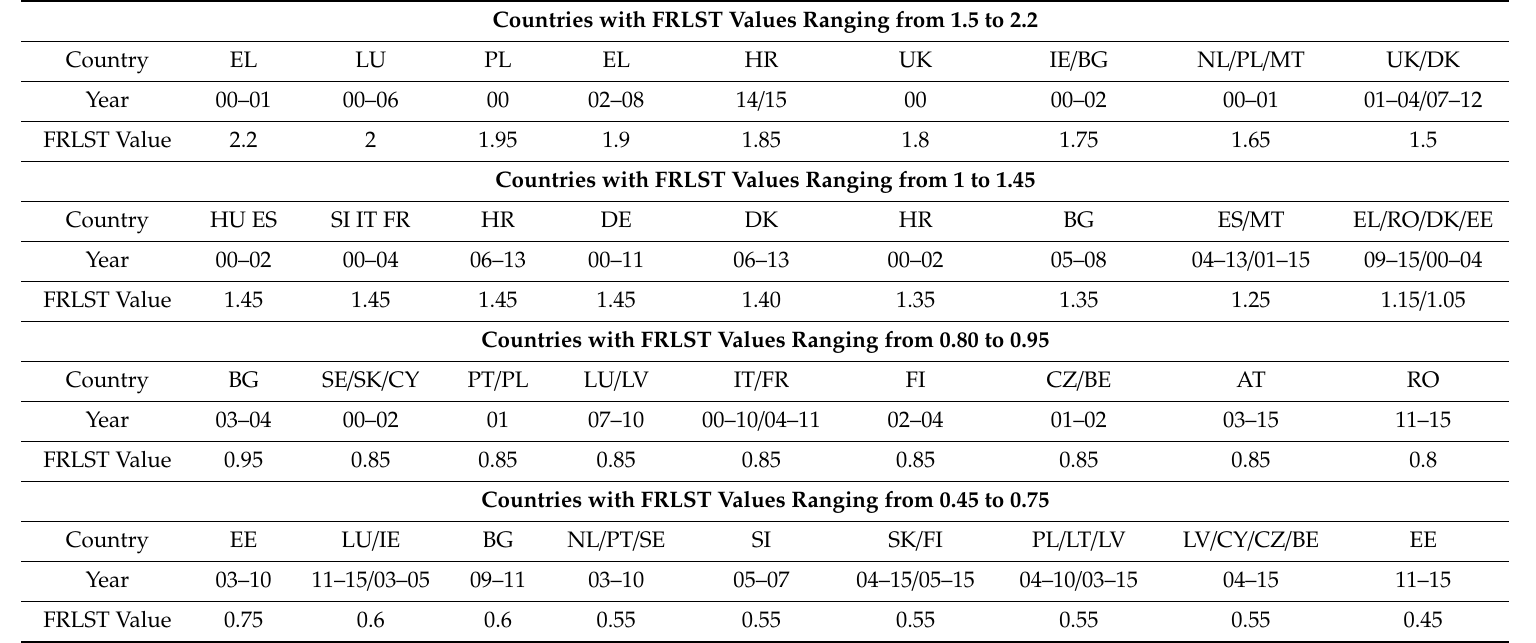
Table 3. Fiscal rules in place (FRLST) in EU